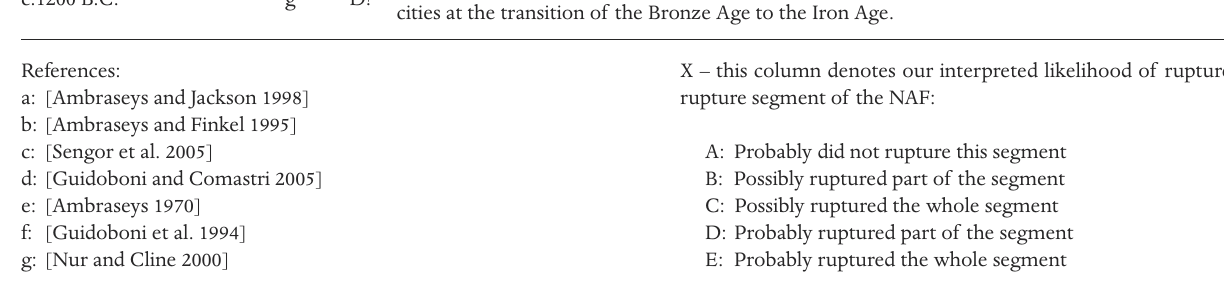
Table 1. Summary of historical earthquakes in the region of the 1939 Erzincan earthquake rupture